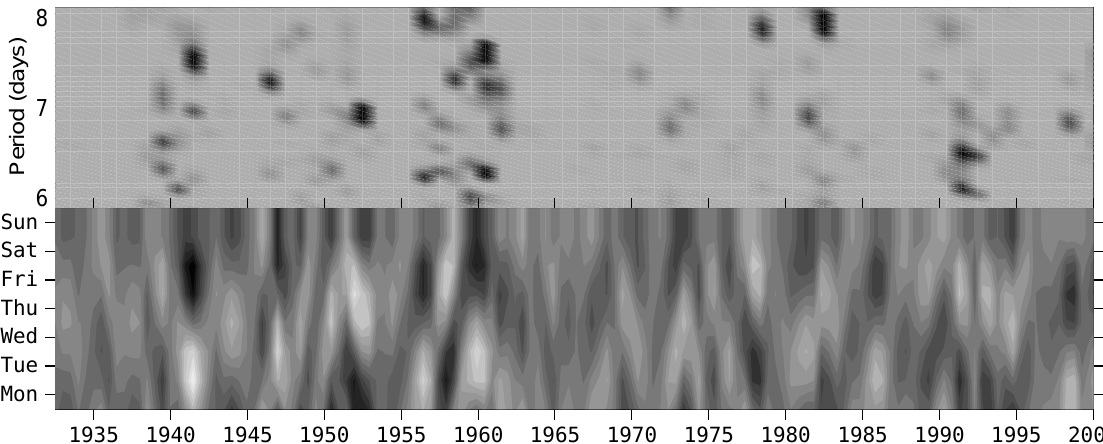
Fig. 2. (top) Dynamic FFT spectrum for the daily A p series in 1932–2000. Black colour represents large intensities. (bottom) Phase presentation for the weekly variation of A p in 1932–2000. Black (white) colour represents large, positive (negative) variations and grey colour represents the zero